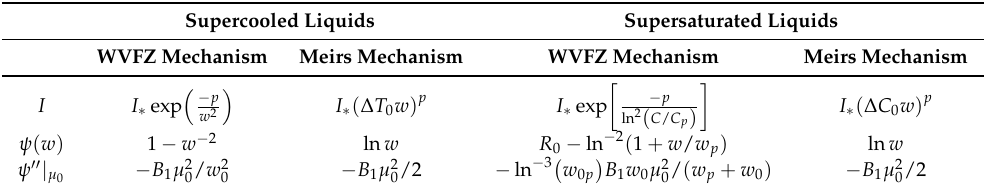
Table 1. Analytical functions for various kinetic mechanisms, R 0 = ln − 2 ( 1 + w − 1 p ) , w p = C p / ∆ C 0 , w 0 p = 1 + w 0 / w p and C = ∆ C + C p